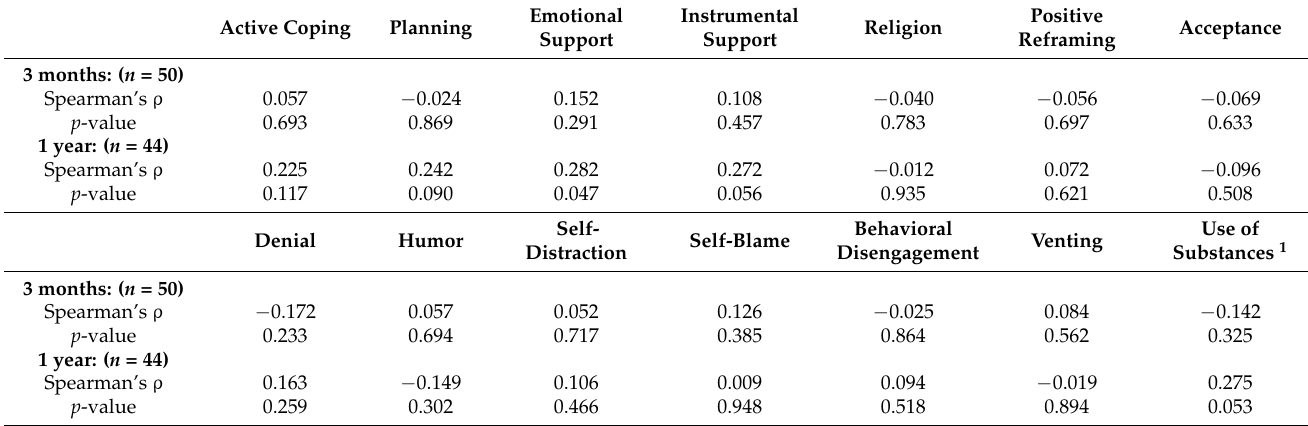
Table 4. Correlation between each of the COPE-28 items and the pain/discomfort dimension of the EQ-5D scale considered as a score at 3 months and at 1 year after stroke.